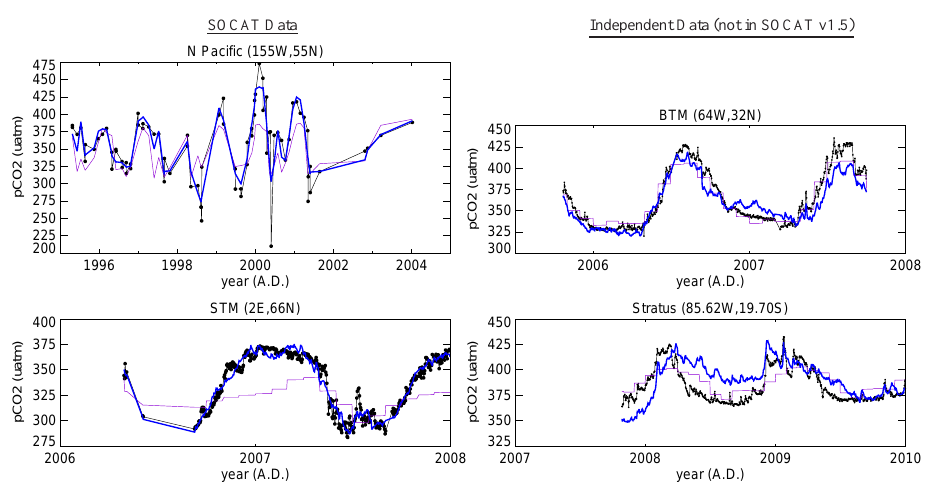
Fig. 8. Comparison between the estimated p CO 2 field (run SFC , blue) and measurements (black dots) at test locations. Left: Data contained in SOCAT v1.5 (larger dots) at a pixel in the North Pacific, and the pixel around Station M in the North Atlantic. Right: Two mooring sites in the North Atlantic (BTM, (64 ◦ W,32 ◦ N)) and South Pacific (Stratus (85.62 ◦ W,19.70 ◦ S)) by Sabine et al. (2010) that are not part of SOCAT v1.5 (smaller dots). The p CO 2 field has been picked at the times where the measurements exist (connected by straight lines for clarity); the time axes have been limited to respective years with data. The monthly climatology by Takahashi et al. (2009) (regridded and with added trend parallel to the atmospheric CO 2 increase, violet) is also given. See Supplementary material for comparisons to SOCAT data (Figure S7.5) and independent data (Figure S7.6) at further locations.